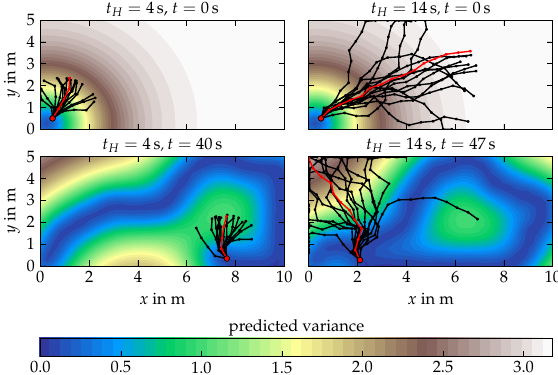
Figure 12. Illustration of the PI-STKF algorithm using different time horizon lengths t H . The optimal path ( | ) starting at the current agent position ( • ) is computed by an iterative sampling of several potential paths ( | ) which are then weighted according to their probabilities which depend on the predicted